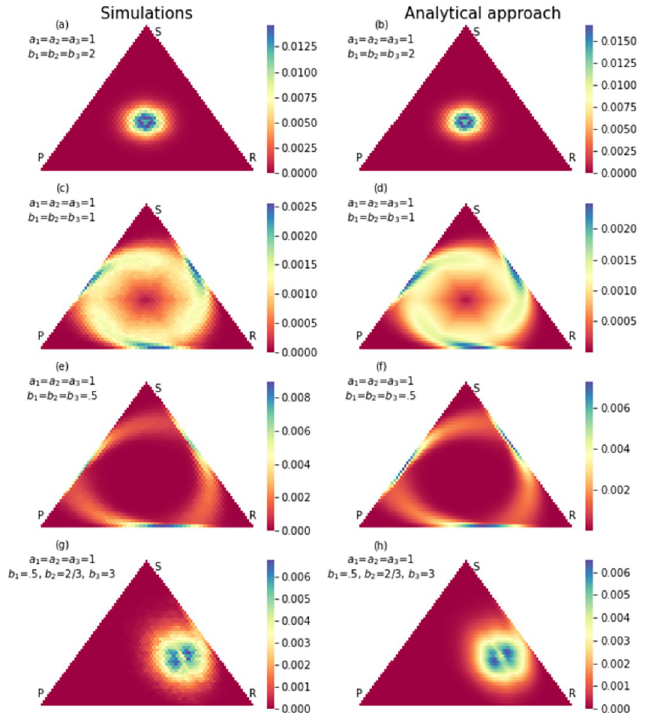
Fig 9. Stationary probability distribution of RSP game with population 50. The update rule is according to Eq 10. The payoff matrix in (a) and (b) is a i = 1, b i = .5 in (c) and (d) a i = 1, b i = 1 and in (e) and (f) a i = 1, b i = 2. To evaluate non-neutral selection in (g) and (h) the payoff matrix set as a i = 1, b 1 = .5, b 2 = 2/3, b 3 = 3.